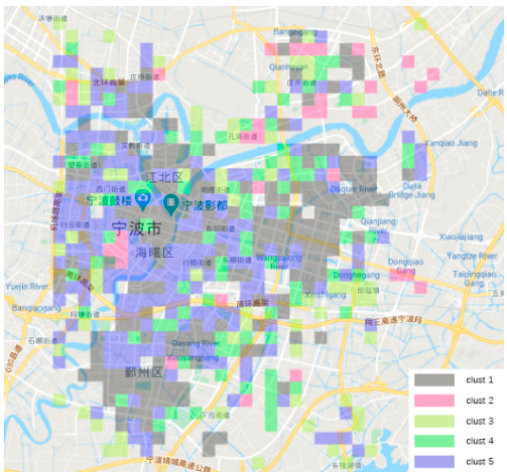
Figure 7. Land distribution of five blocks.